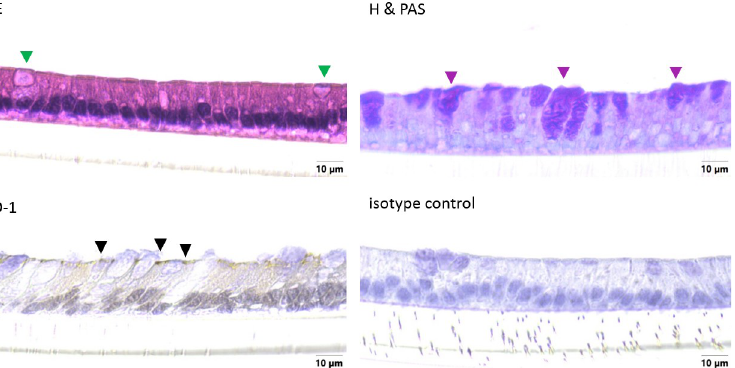
Fig 4. Cellular arrangement (cross sections) of jejunum organoids grown in 2D on Snapwells 1 for 18 days. Cells were either stained with hematoxylin and eosin (H & E) or hematoxylin and PAS (H & PAS) as well as immunohistochemical staining (including isotype controls) of ZO-1 (cross-section). Green triangles indicate cells with a goblet, cup-like appearance, violet triangles indicate PAS-positive cells and black triangles show a positive signal of ZO-1. Representative figures are shown, chosen from three independent experiments with three technical replicates per staining.